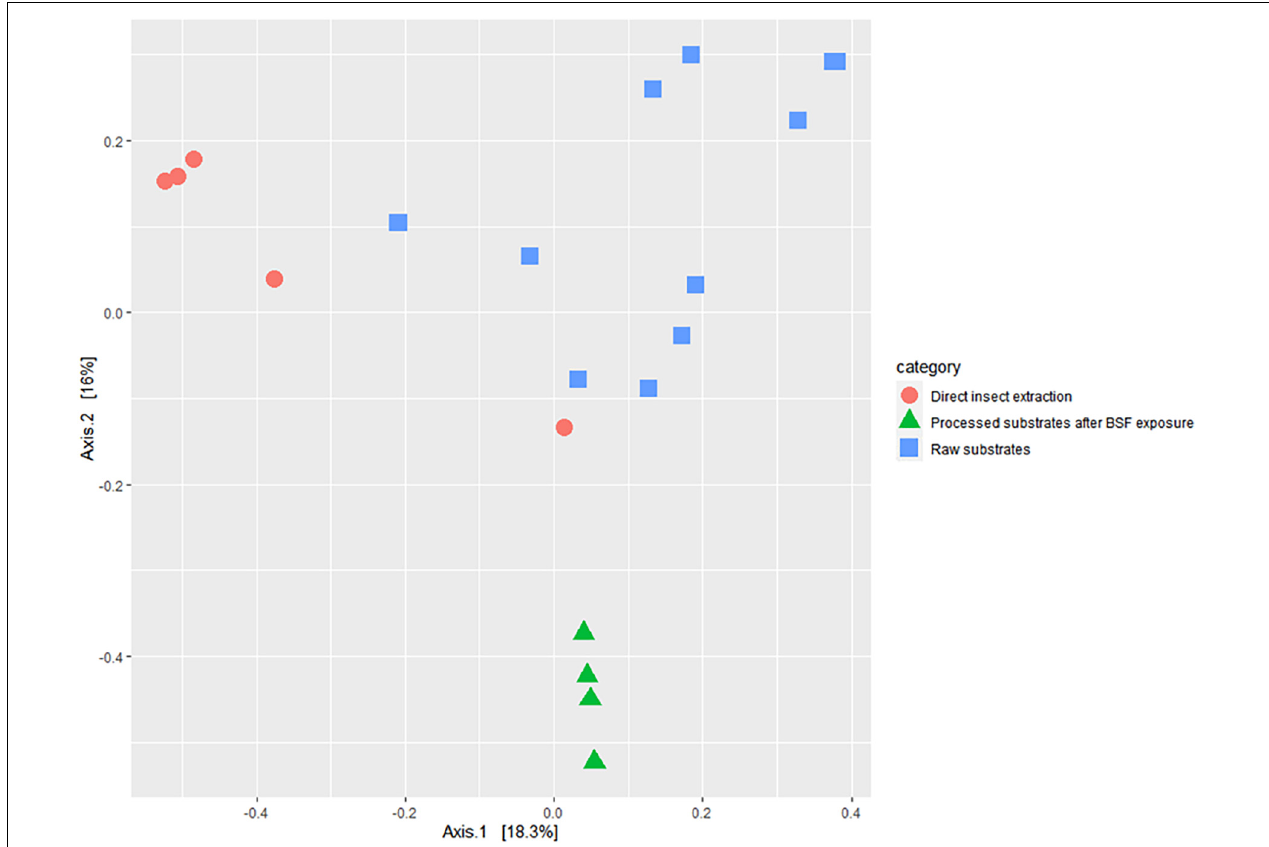
FIGURE 7 | Two-dimensional principal coordinate analyses plot of the beta diversity of bacterial genera in the black soldier fly larvae (BSFL) and its substrates, estimated using the Bray Curtis dissimilarity index